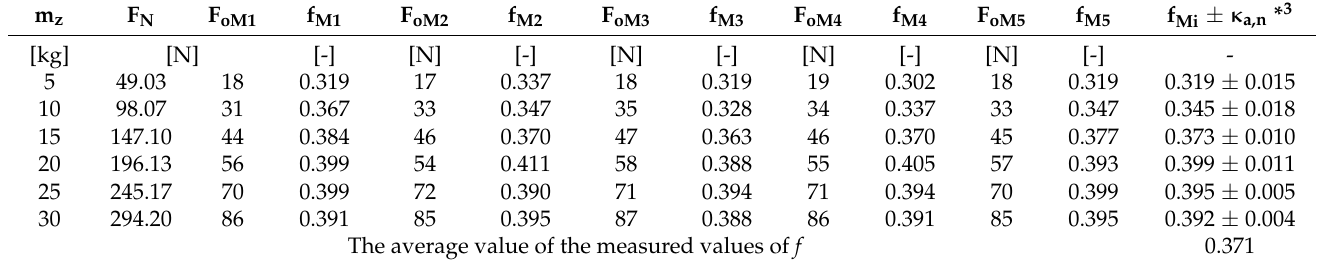
Table 5. Coefficient of friction, groove contaminated with oil, 10 mm diameter cable.